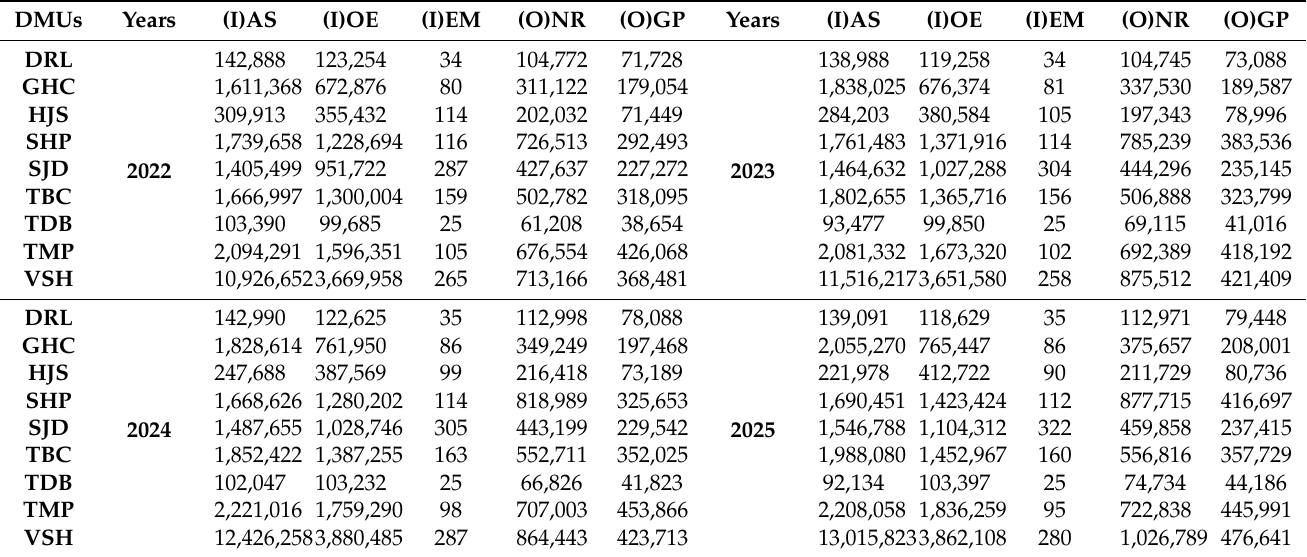
Table A1. Forecasted values of hydropower suppliers from 2022 to